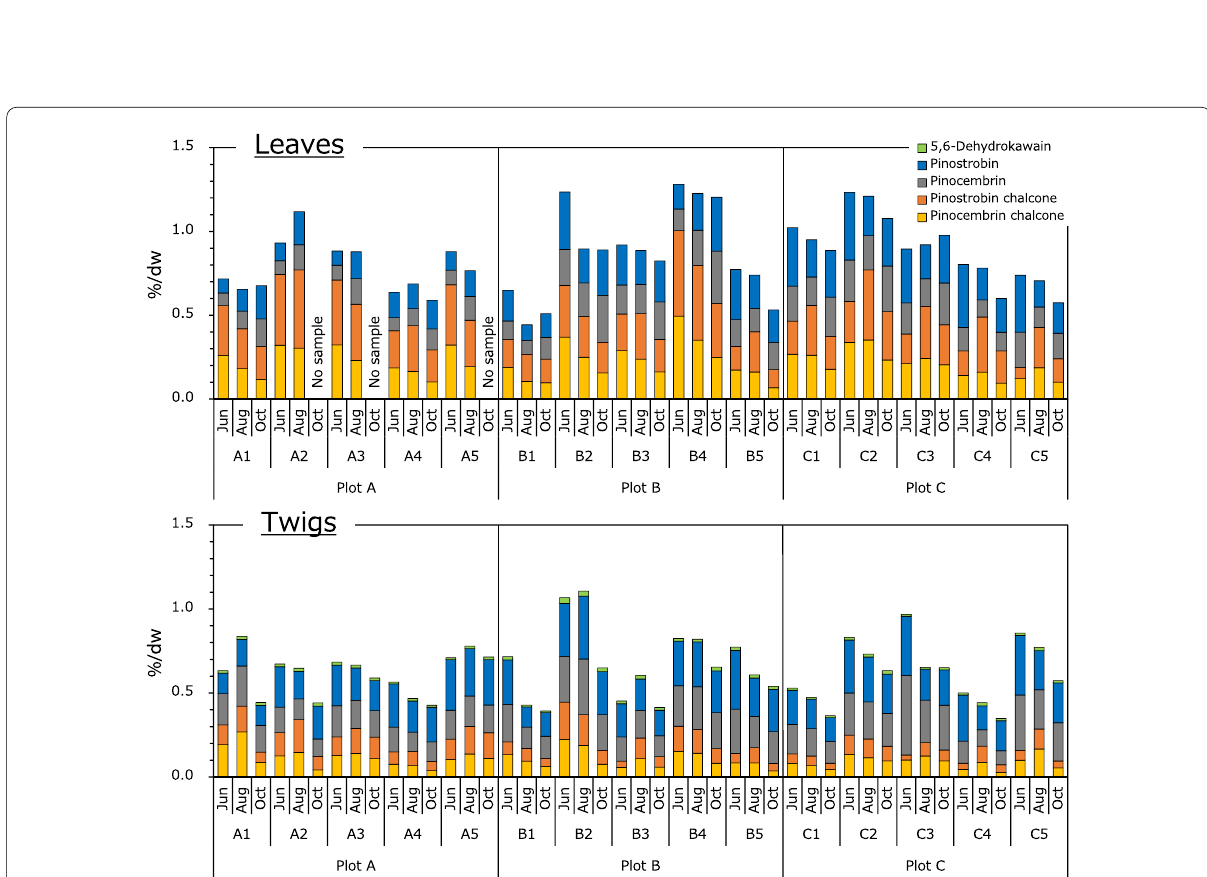
Fig. 8 Quantitative analyses of the five major flavonoids detected in the 70% acetone